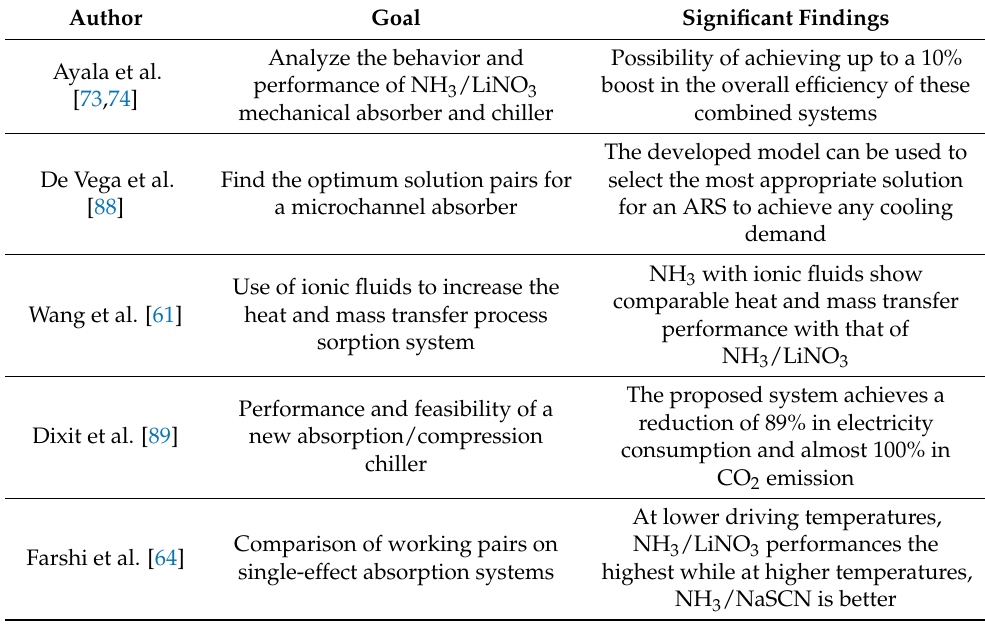
Assessment of absorption refrigeration systems using the theoretical/numerical